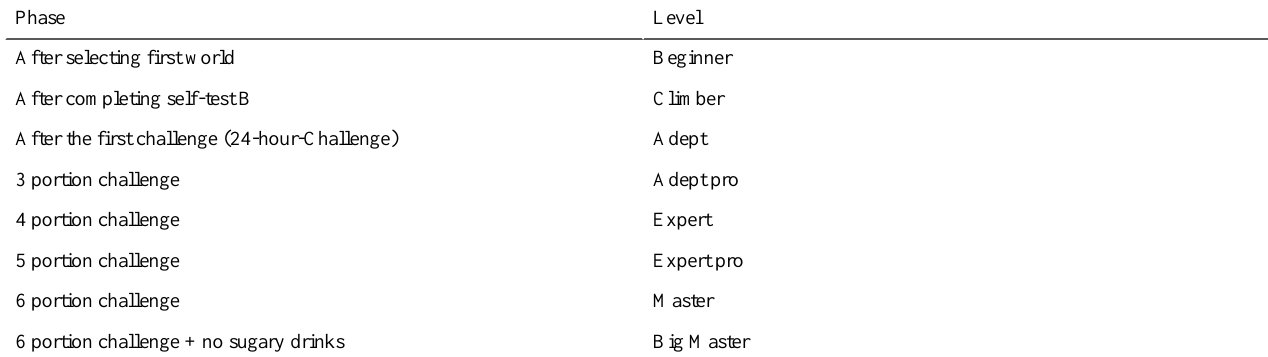
Table 5. Levels in the drinking world of the app.